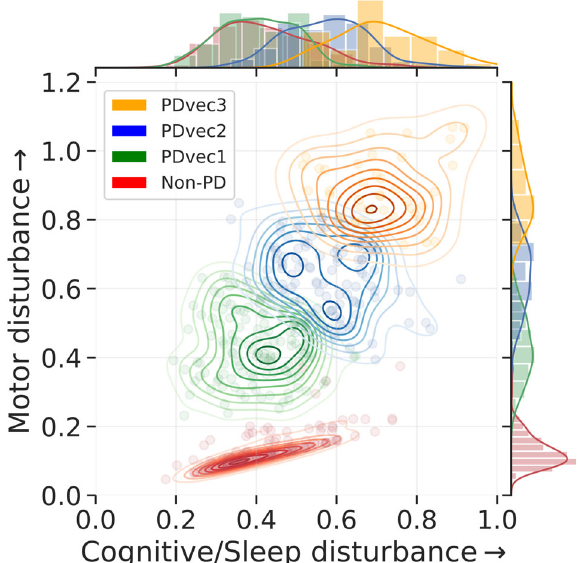
Fig. 3 PD fi ve-year progression space. Visualization of unsuper- vised learning via GMM on two-dimensional progression space and identi fi cation of three Gaussian distributions representing three distinct PD subtypes. An increase in value along either direction re fl ects the increase in the disturbance on a normalized